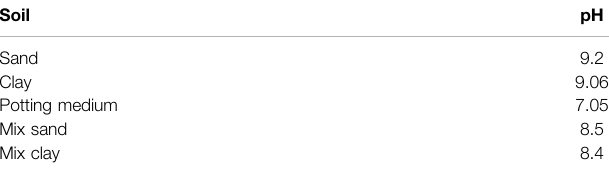
TABLE 2 | Determined pH of soils and mixed soils used in this study.